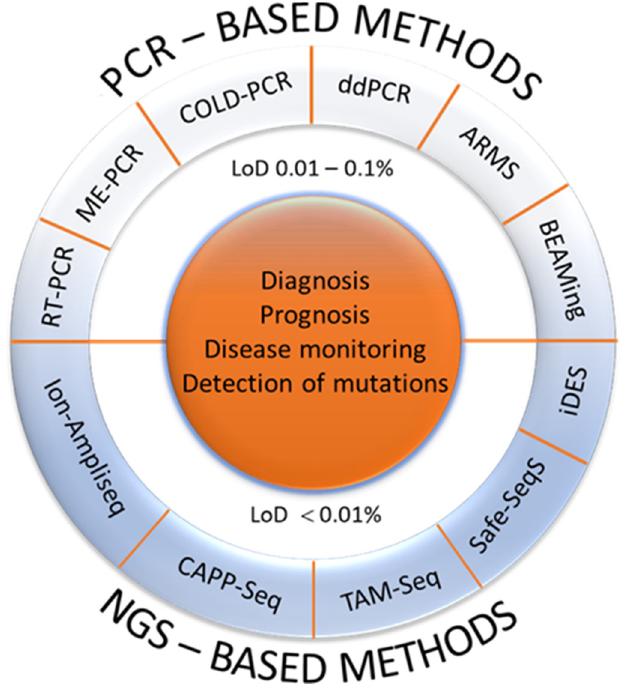
Figure 2. Current methods for identification and analysis of ctDNA. Based on the technologies which are used for ctDNA analysis, PCR- and NGS-based methods emerged. In general, PCR-based methods are cost-effective, rapid and no specific informatic skills are needed but the main disadvantage is that they can detect a limited number of known mutations. On the other hand, NGS is based on the analysis of several millions of short DNA sequences in parallel, followed by either sequence alignments to a reference genome or a de novo sequence assembly. Therefore, the NGS-based methods are expensive and time-consuming, but can detect a large number of mutations. Furthermore, according to the methodological approaches and analytical sensitivity, there are also two strategies for ctDNA analysis: (i) targeted methods with high resolution such as ARMS, ddPCR, BEAMing which in most cases determine only a single or a few mutations with a high analytical sensitivity and (ii) more comprehensive or untargeted, genome-wide approaches, which require a certain amount of tumor DNA in the circulation, typically 5–10%, in order to achieve informative results. To date, there is no consensus regarding methods that could eventually find a practical application since the clinical and practical application depends on individual situation and the goal of the ctDNA analysis [65,66]. (PCR, polymerase chain reaction, RT-PCR, real-time PCR; ME-PCR, mutant-enriched PCR; COLD-PCR, co-amplification at lower denaturation temperature PCR assays; ddPCR, droplet-based digital PCR; ARMS, amplification refractory mutation system; BEAMing, beads-emulsion-amplification-and-magnetics; NGS, next generation sequencing; CAPP-Seq, cancer personalized profiling by deep sequencing; TAM-Seq, tagged-amplicon deep sequencing; Safe-SeqS, Safe-Sequencing System; iDES, integrated digital error suppression; LoD, limit of